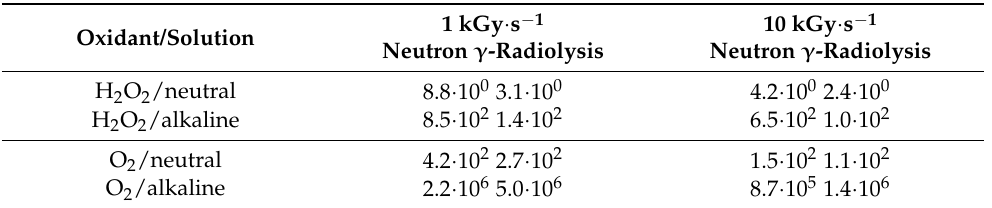
Table 3. Effectiveness of hydrogen addition expressed as a ratio of the steady state concentration in the absence of extra hydrogen and in the solution containing 1.5 · 10 − 4 mol · kg − 1 H 2 . Oxidant/Solution